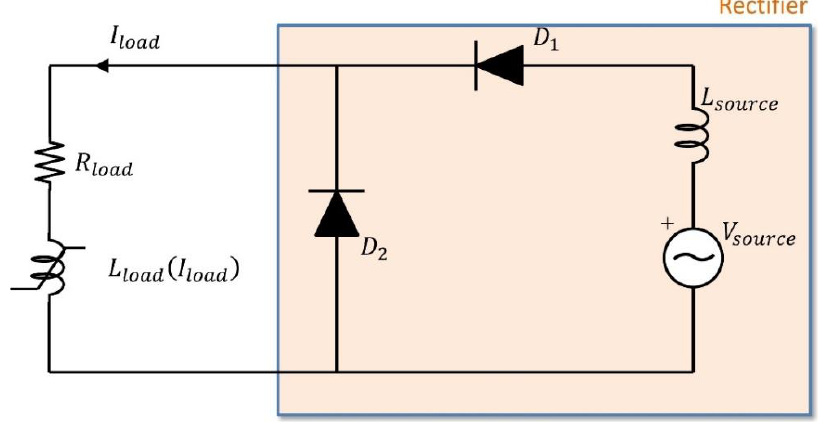
Figure 9. Schematic of a half-wave rectifier flux pump supplying the field winding of the HTS genera- tor . Table 4. Rectifier flux pump — equivalent circuit parameters.